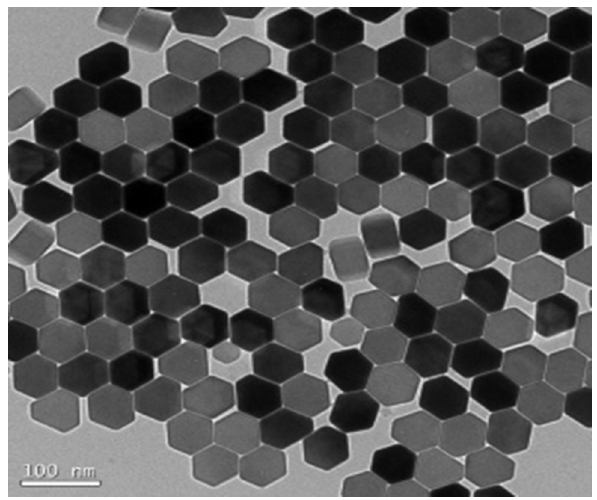
Figure 1. Transmission electron microscopy images of 70 nm bare upconversion nanoparticles